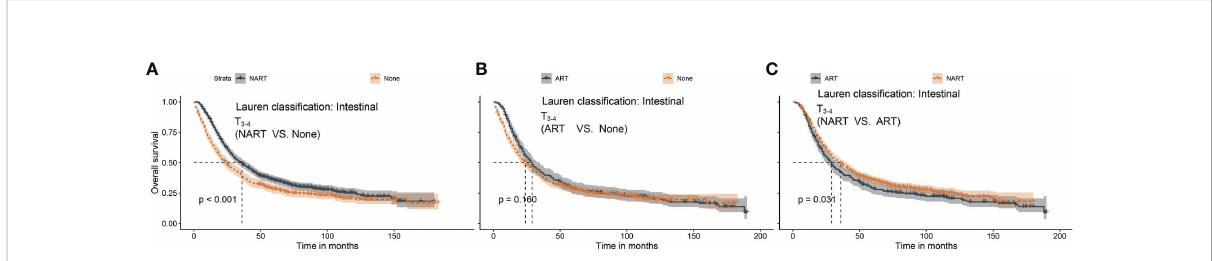
FIGURE 5 (A – C) Survival bene fi t after NART or ART in T 3 – 4 patients with intestinal type. (A) NART prolonged survival in T 3 – 4 patients with intestinal type. (B) ART failed to bene fi t survivors in T 3 – 4 patients with intestinal type. (C) Overall survival after ART was worse than that after NART in T 3 – 4 patients with intestinal type. NART, neoadjuvant radiotherapy; ART, adjuvant